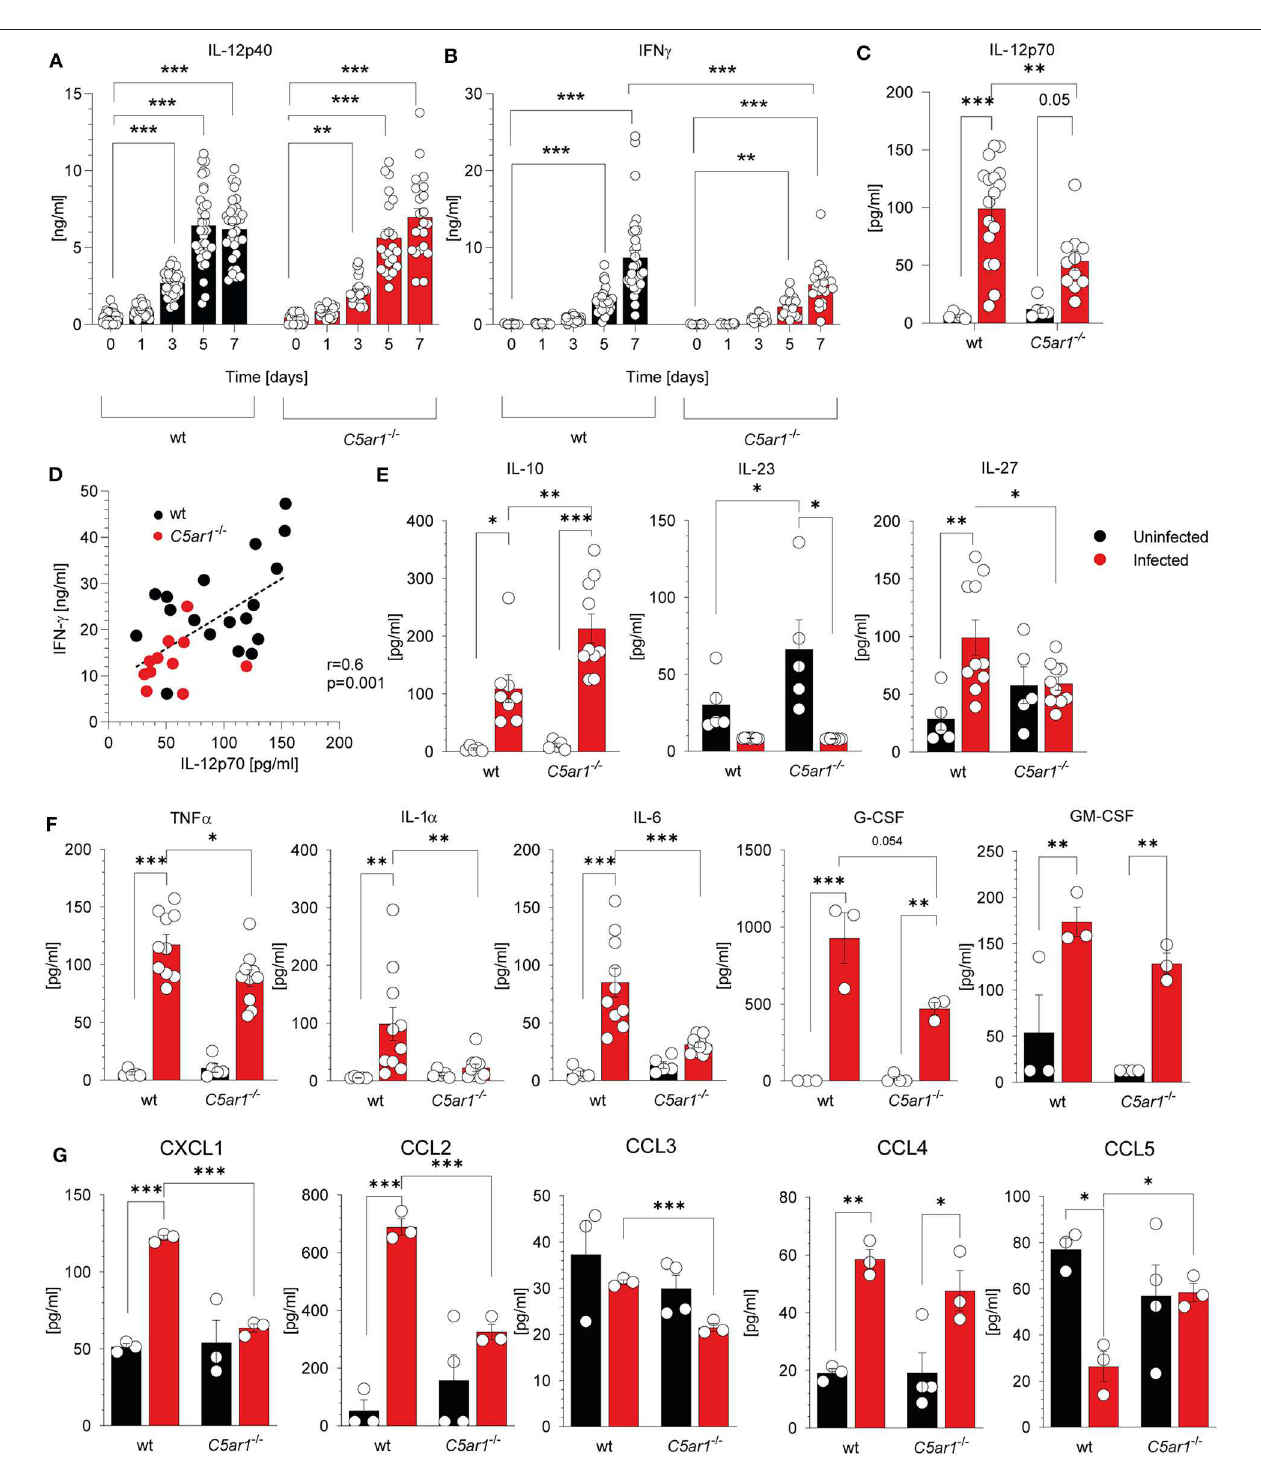
FIGURE 4 | C5aR1 activation drives systemic cytokine and chemokine production during the early phase of T. gondii infection. (A) Kinetics of IL-12p40 and (B) IFN- γ serum concentrations in wt and C5ar1 − / − mice after T. gondii infection. Serum samples were obtained before and 1, 3, 5, and 7 days after infection. Cytokine levels were determined by ELISA. The data are from three independent experiments, n = 22–33/condition. (C) IL-12p70 cytokine serum concentrations in wt and C5ar1 − / − mice 7 days after T. gondii infection as determined by bioplex assay (Meso Scale Discovery); n = 10–17/condition. (D) Linear regression analysis between IL-12p70 and IFN- γ serum concentrations 7 days after infection. The p -value was calculated using the Pearson’s correlation coefficient, n = 29 pairs. (E) IL-10, IL-23,